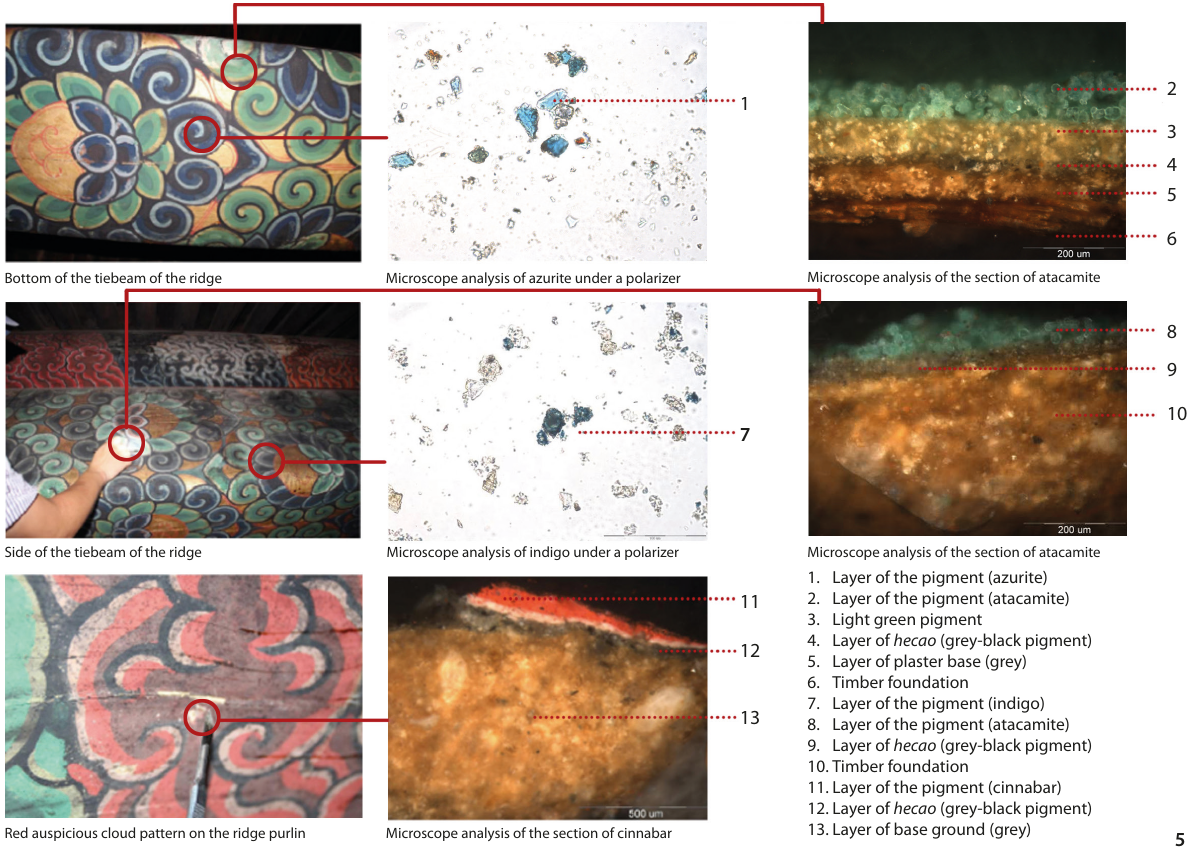
Side of the tiebeam of the